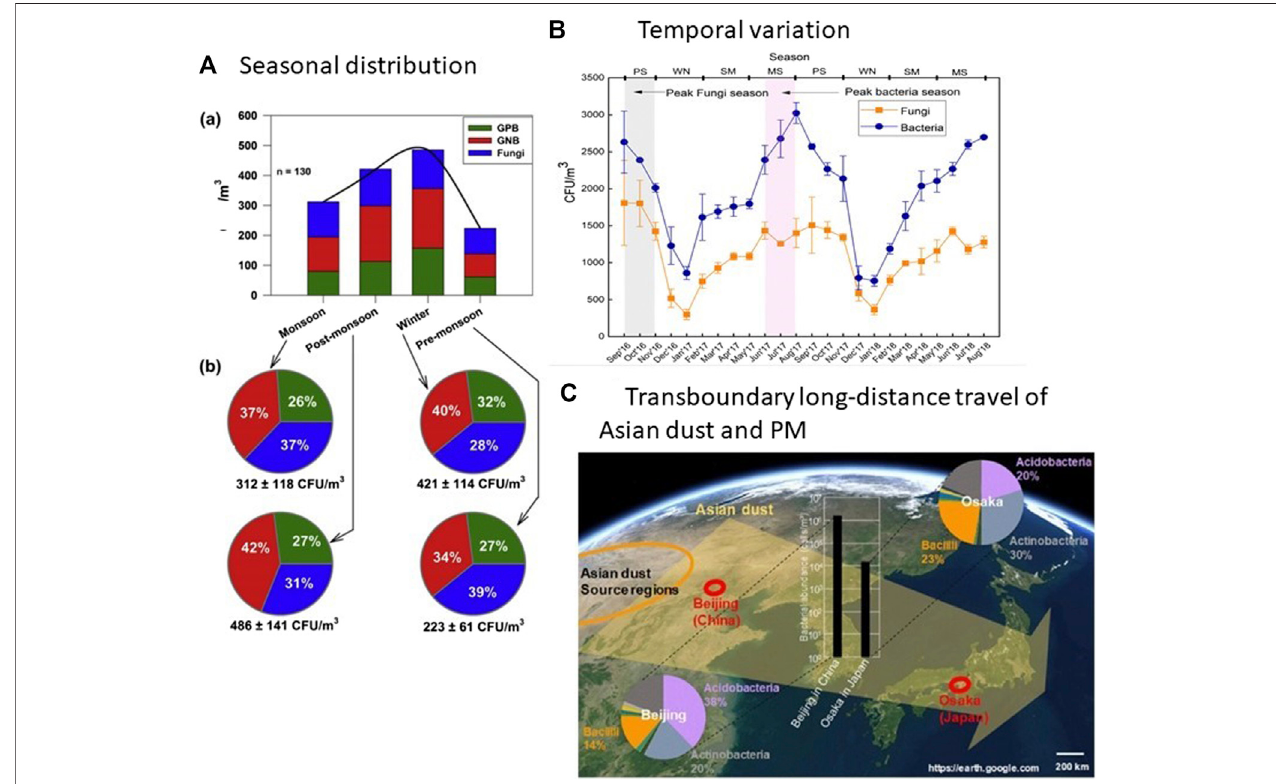
FIGURE 1 | (A) Seasonal variability of total viable bioaerosols [Gram-positive bacteria (GPB)+ Gram-negative bacteria (GNB)+ Fungi] and percentage fractions of GPB, GNB, and Fungi colonies collected from biomass burning of Kanpur, India (Rajput et al., 2017). (B) Temporal variation in fungal and bacterial concentrations at a high traf fi c density junction in Dehradun city, India (PS: post-monsoon, WN: winter, SM: summer, MS: monsoon) (Madhwal et al., 2020). This seasonal pattern is suspected to be similar for all tropical South and South-East Asian cities. (C) Asian dust incidents and the impact on airborne bacterial populations at different distances from the source area to the downwind region (Park et al.,